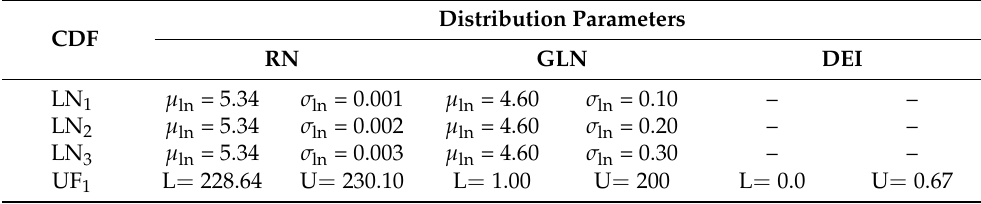
Table 4. Loading parameter